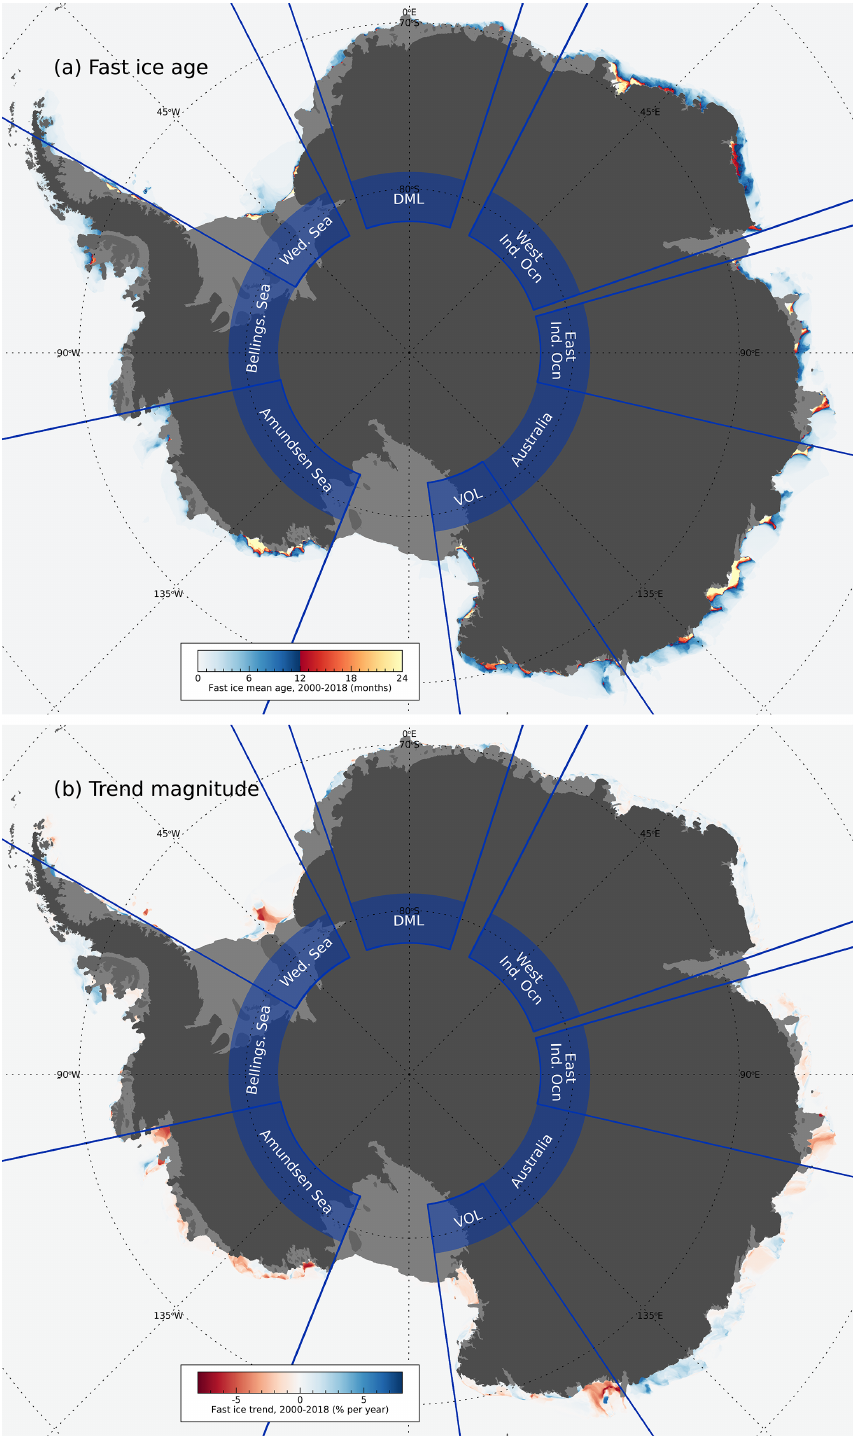
Figure 4. (a) Mean fast-ice age over the 18-year study period. White to blue pixels indicate seasonal fast ice. The colour break from a blue hue to a red hue at 12 months is chosen to highlight regions of multi-year fast ice (red-yellow hues). (b) Per-pixel trends in fast-ice extent (%yr − 1